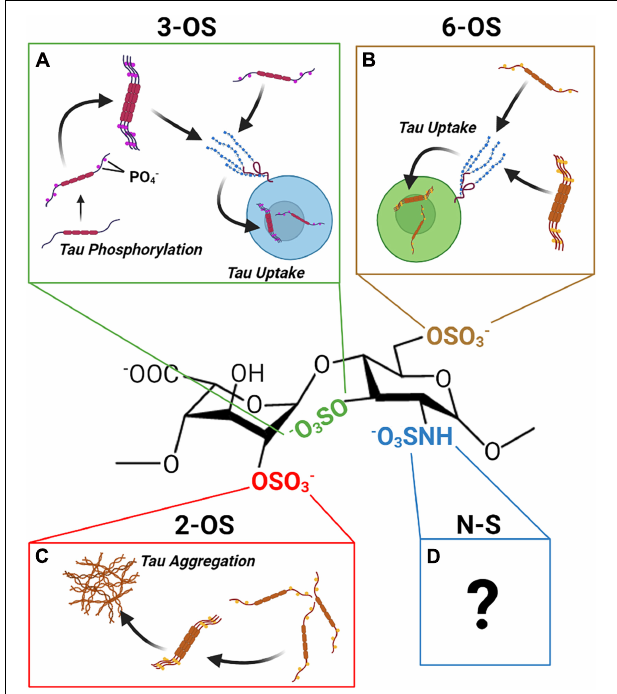
FIGURE 8 | The Discrete Functions of HS Sulfation Sites. The different HS sulfation sites are associated with different interactions with tau protein. (A) 2- O HS sulfation may promote aggregation of tau. (B) 6- O HS Sulfation enhances tau protein HS binding and HSPG mediated uptake of tau. (C) 3- O HS Sulfation is associated with enhanced tau phosphorylation as well as enhanced tau binding and uptake. (D) Though tau exhibits an interaction with N-sulfated HS, its functional significance remains